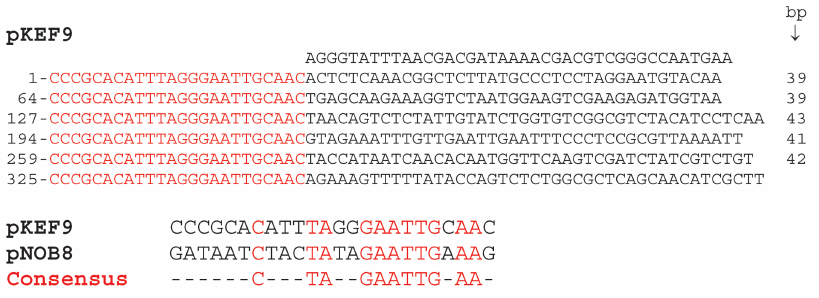
Figure 5. Alignment of short regularly spaced repeat (SRSR) sequences of pKEF9 (red). Conserved sequence po- sitions are indicated. The genome